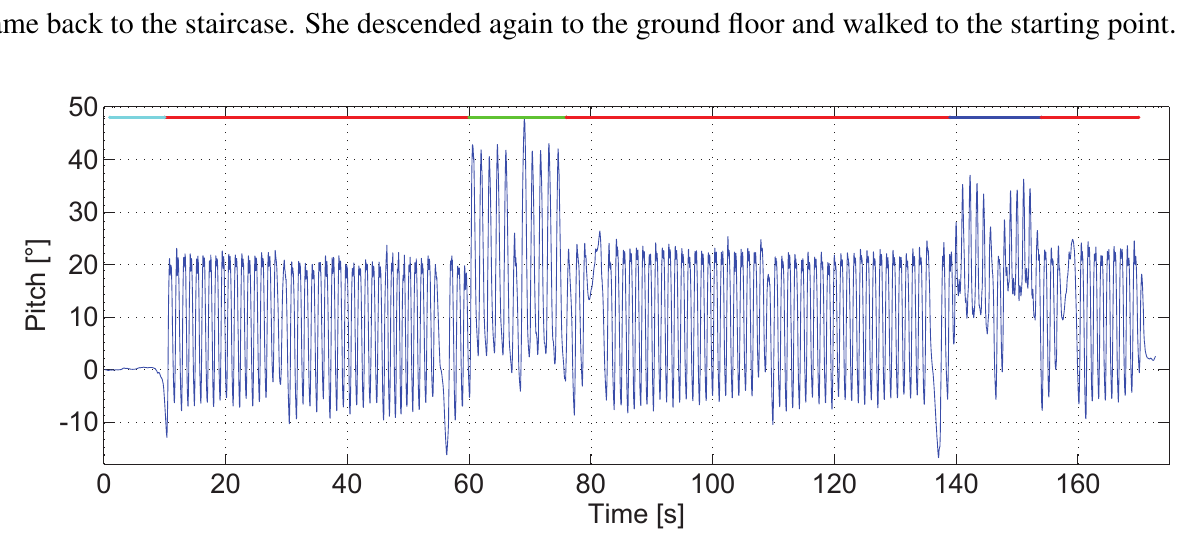
Figure 5. The blue line represents the estimation over time of the pitch angle, measured in degrees, during a multi-storey walk of a pedestrian with the sensor in the